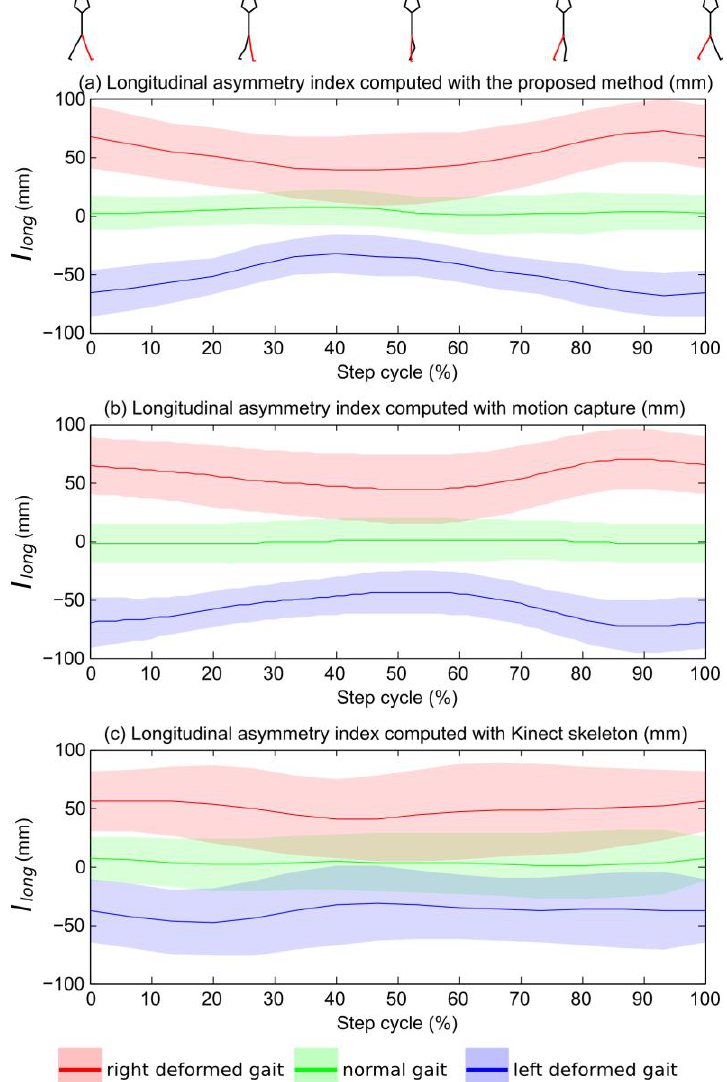
Figure 5. Representation of mean I (i) computed for each group (normal, left deformed, long right deformed) from raw depth data with our method ( a ) from the skeleton computed with the motion capture data ( b ) and from the skeleton computed with the Kinect™ data. The colored zones define standard deviation intervals. An I long value close to zero indicates perfect symmetry of the